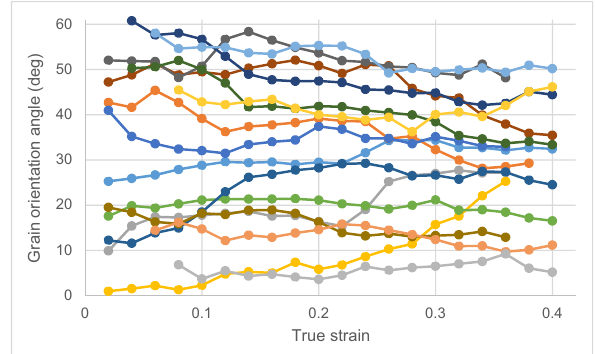
Figure 6: Variation of the orientation angle of each grain with the strain, with di ff erent colors assigned just to di ff erentiate the curves of di ff erent